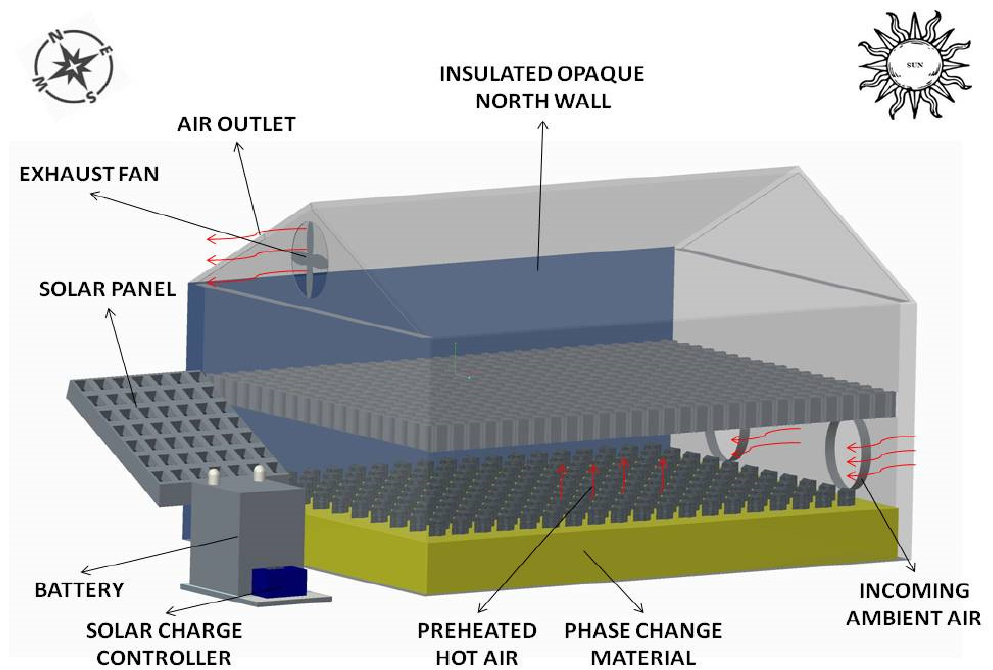
Figure 6. Forced convection solar greenhouse dryer.